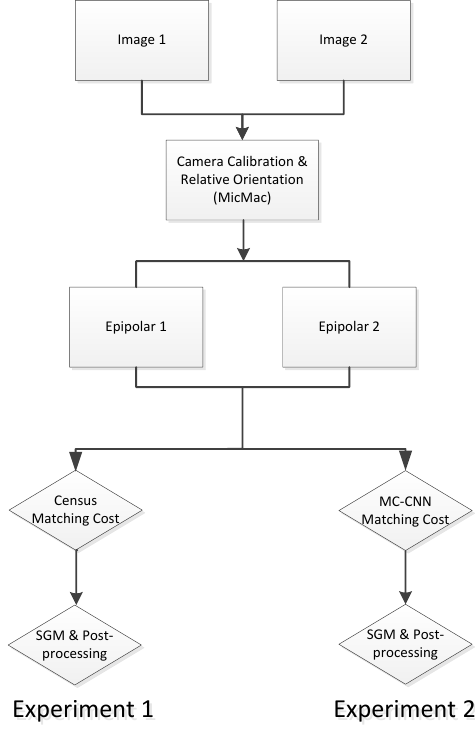
Figure 4. The experiment flow chart